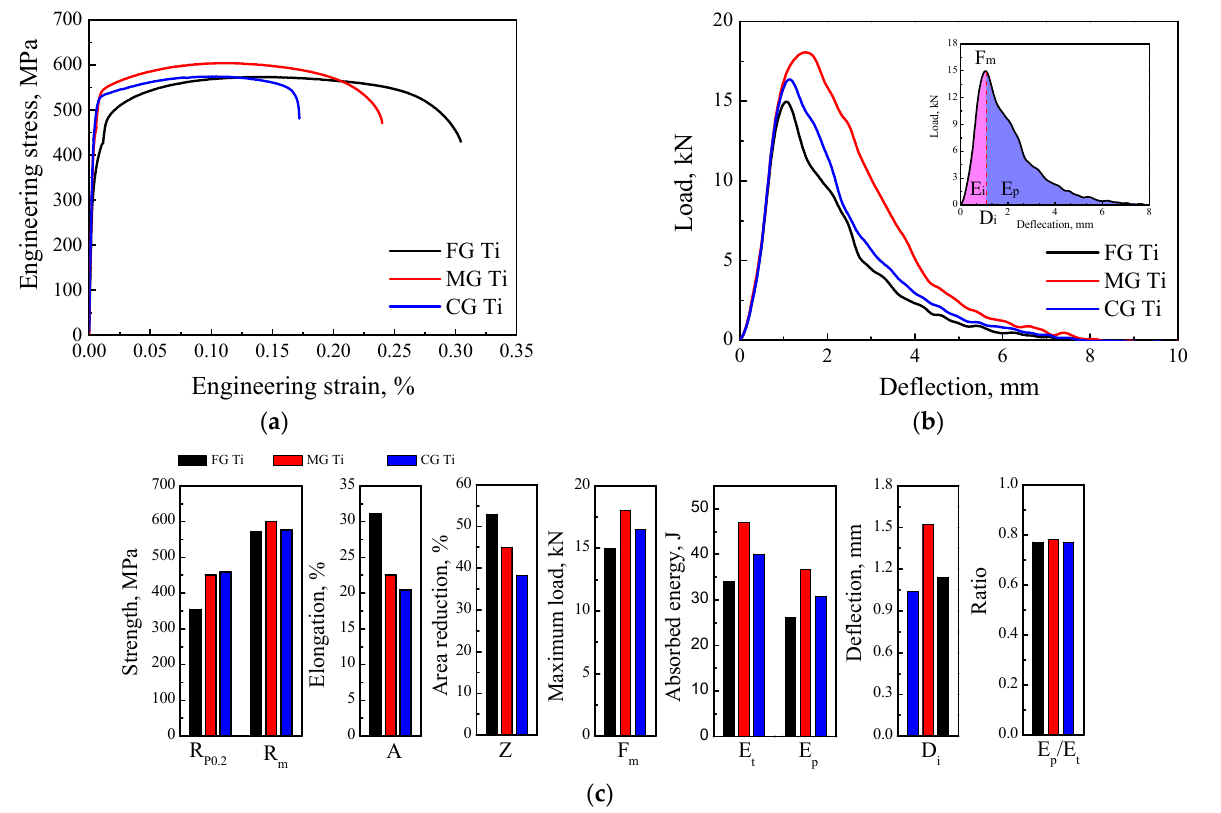
Figure 4. The mechanical properties of the FG Ti, MG Ti, and CG Ti samples: ( a ) tensile engineering stress-strain curves, ( b ) Charpy impact load-deflection curves, and ( c ) the tensile and Charpy impact properties of the three samples. Table 1. The average yield strength (Rp 0.2 ) and elongation to failure (A) of the FG Ti, MG Ti and CG Ti samples.